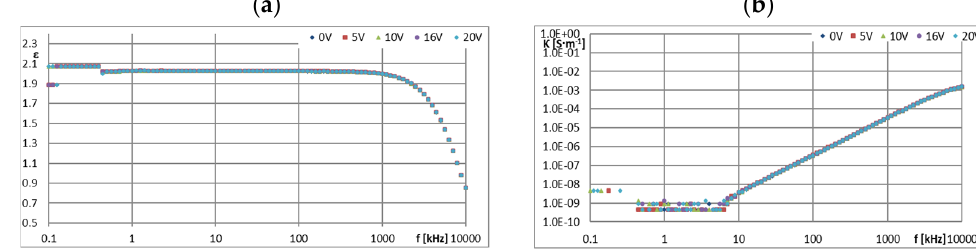
Figure 9. Characteristics: ( a ) ε = f( f ) and ( b ) κ = f( f ) for GP1 + CJ001 at different values of U. ( a ) ( b ) Figure 10. Characteristics: ( a ) ε = f( f ) and ( b ) κ = f( f )for PAO6 + CJ008 at different values of U.